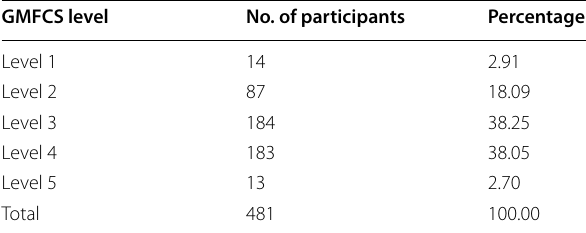
Table 7 Distribution of levels of disability in children with